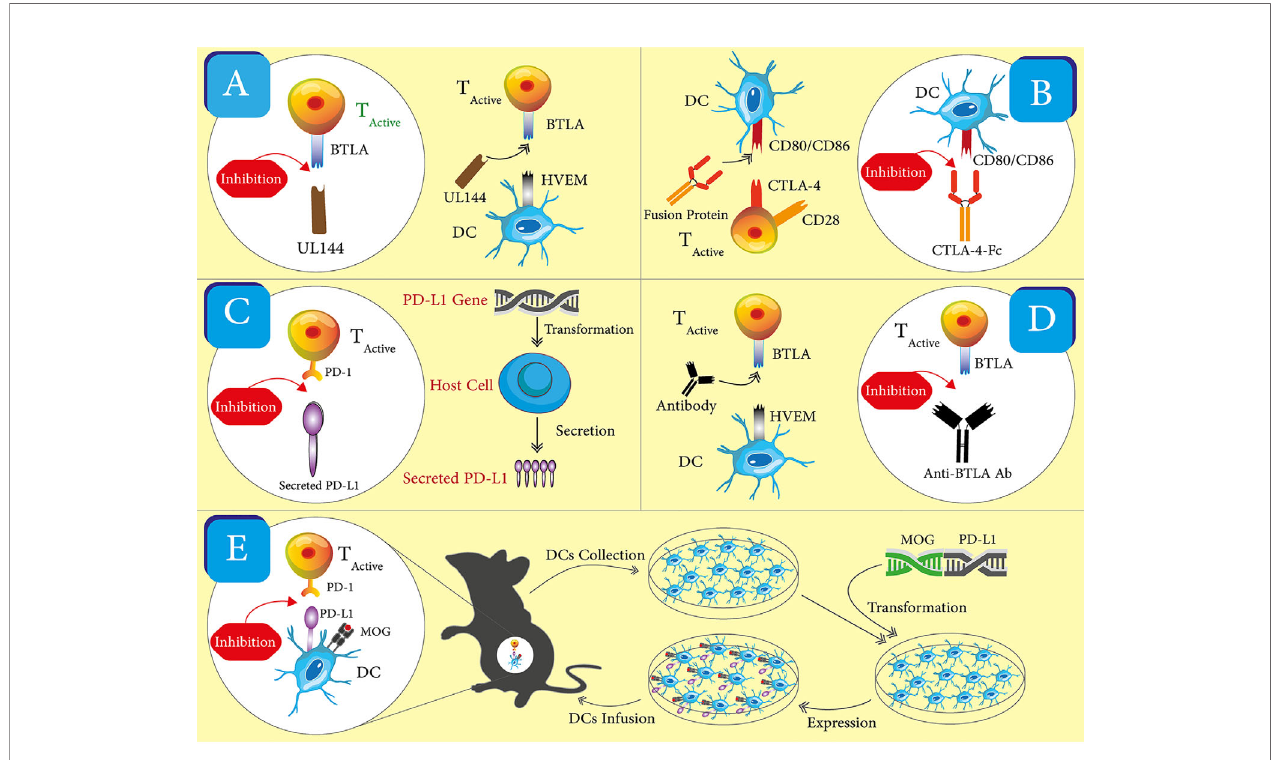
FIGURE 2 | Schematics for the different forms of ICP-targeting therapeutics. One representative for each form of therapeutics was shown. (A) Viral proteins. UL144 is used to engage with BTLA and activate the corresponding ICP, which enhances immune inhibitory signals. (B) Soluble ligand and receptors. A fusion of CTLA-4 and Fc is used to engage with CD86/CD86 and activate the CTLA-4 ICP, which enhance immune inhibitory signals. (C) Nucleic acids. A coding gene of PD-L1 is used to increase the expression of PD-L1 in host cells. The increased expression strengthens the PD-1 ICP and immune inhibitory signals. (D) Antibodies. An anti- BTLA antibody is used as an agonist to enhance the BTLA ICP, which ampli fi es immune inhibitory signals. (E) Cells. DCs are collected and transfected with the coding genes of PD-L1 and MOG peptide. These engineered DCs have the enhanced expression of PD-L1 and MOG peptides. After these DCs are transferred back into mice, they promote immune inhibitory signals in vivo through the PD-1 ICP and the presentation of the MOG peptide to T cells.